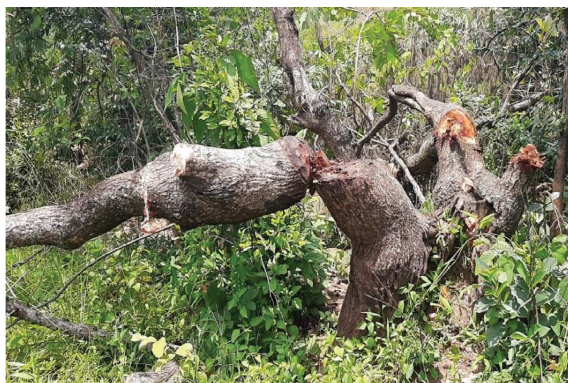
Figure 4: Illegal cutting of tree/shrub species from forest stands in Ofa woodlands. source: observations (feld photo by author (2018/ Table 2: Socioeconomic characteristics of the sampled household heads/charcoal producers and their association with forest degradation in Ofa Woreda, Wolaita Zone ( n � 98).